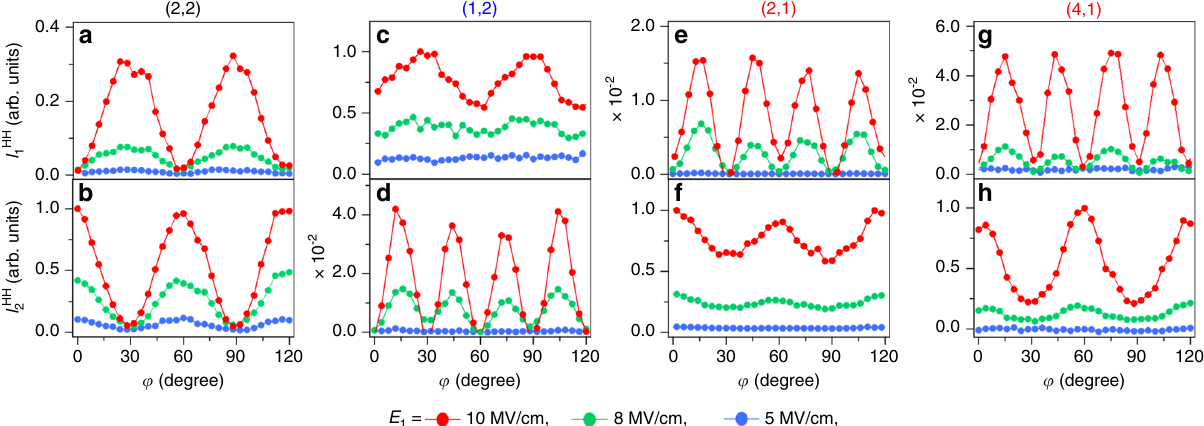
component on φ for the (2,2) order as a representative of 1 on φ and E 1 . c – h Corresponding 2 or I HH for each order is normalized, and their intensity ratios for the same order are 1 2